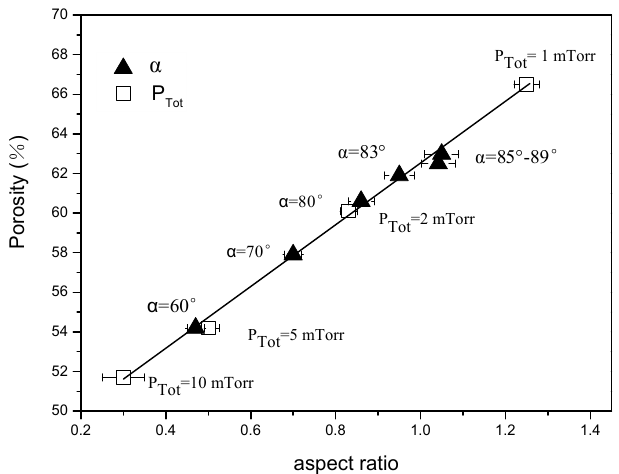
Figure 8. Evolution of the porosity as a function of the aspect ratio, Γ , for Mg nano-sculpted films with the α and P Tot .